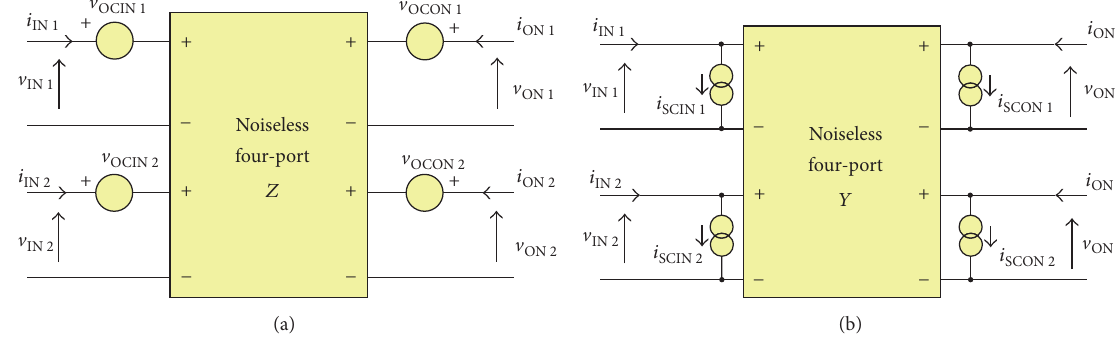
Figure 2: Equivalent circuit for a noisy MIPMOP